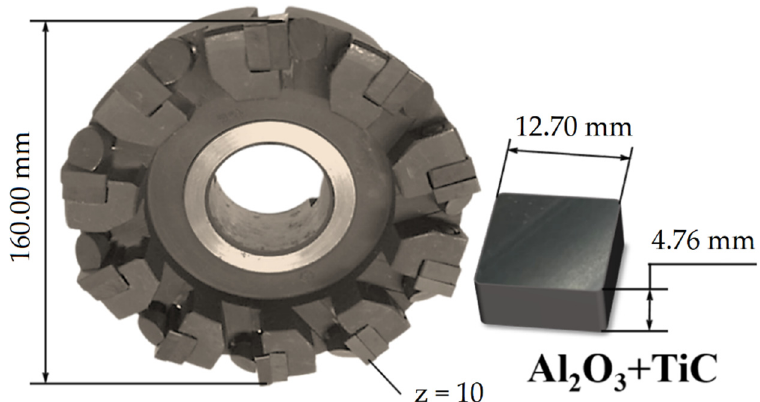
Figure 1. Construction of a prefabricated face mill with mechanical fastening of square cutting ceramic inserts used in testing.